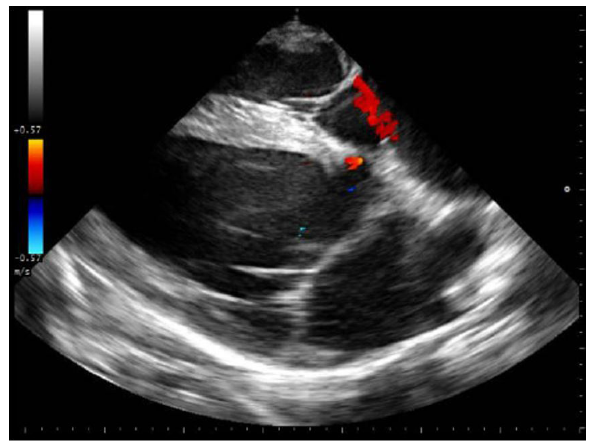
Figure 3. LV longitudinal image showing transeptal flow in the LV outflow tract region.